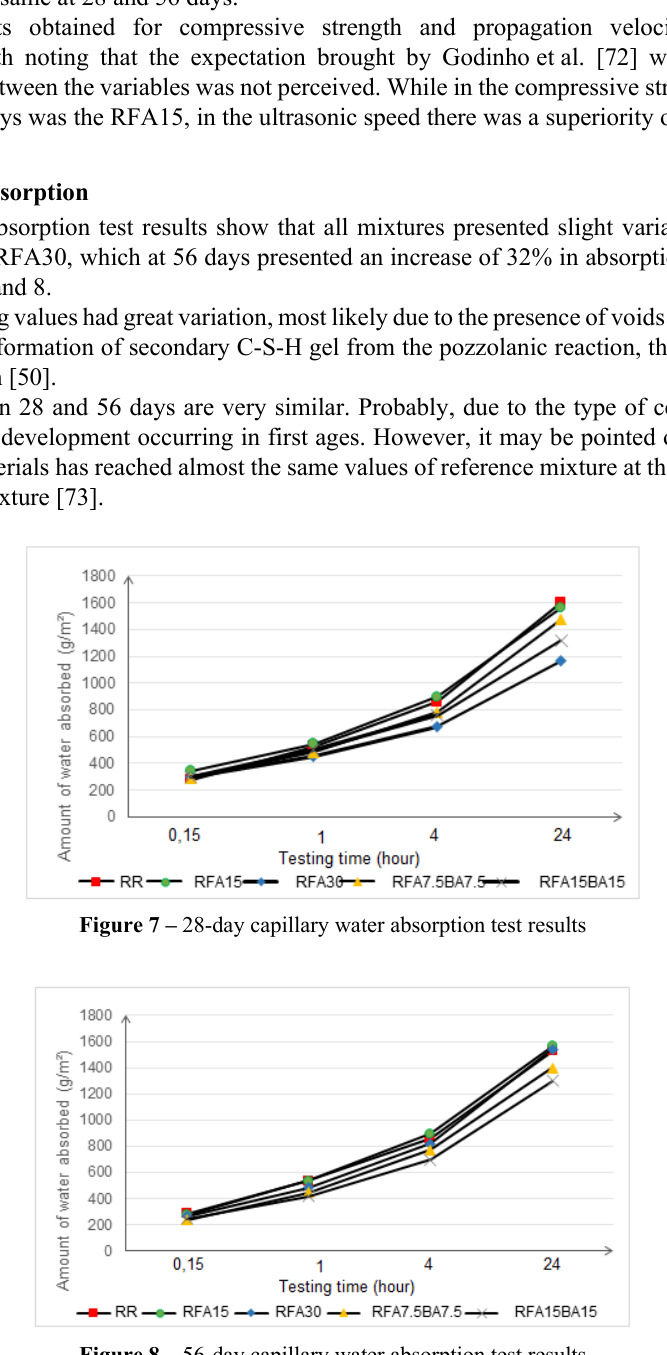
Figure 8 – 56-day capillary water absorption test